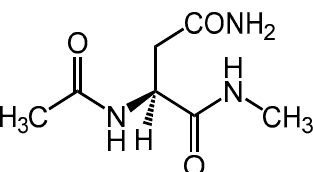
Figure 7. The structure of the model compound.